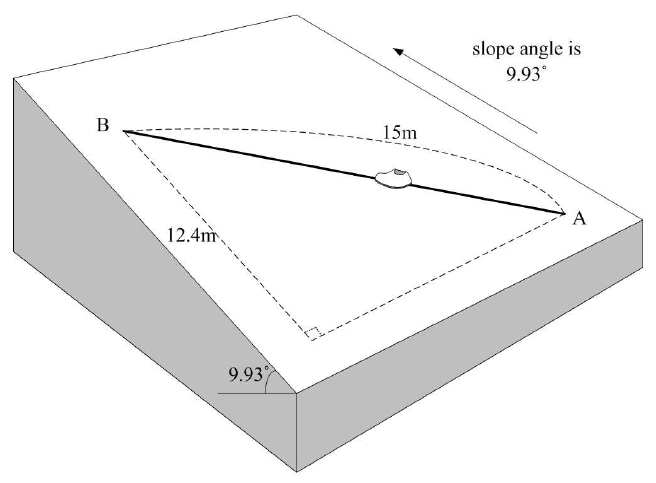
Figure 11. Height compensation experiment while walking up and down the slope